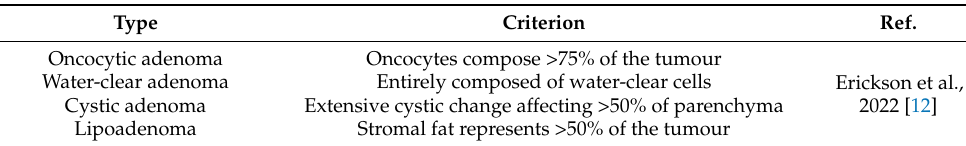
Table 1. Diagnostic criteria for specific types of parathyroid adenomas. Type Criterion Ref. Oncocytic